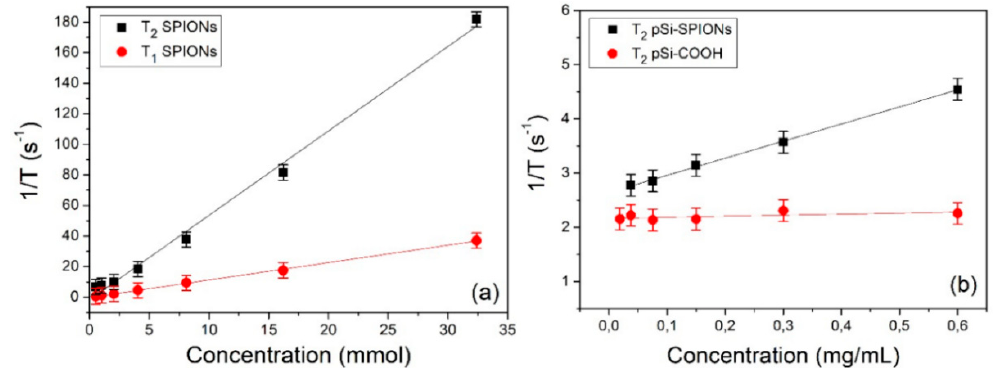
Figure 9. Relaxivity determination: ( a ) 1/T 1 and 1/T 2 relaxation rates of SPIONs as a function of the iron concentration; ( b ) 1/T 2 relaxation rate of pSi-SPIONs and pSi-COOH microparticles as a function of the microparticles concentration.